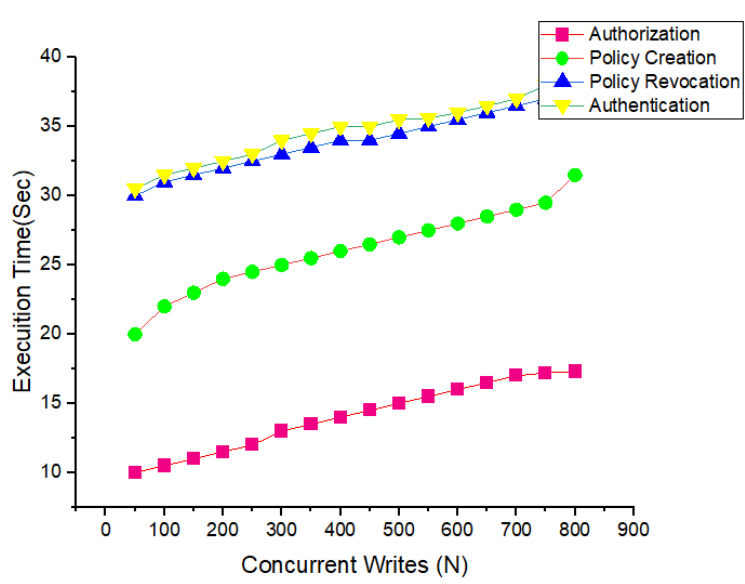
Figure 8. Simulation results of our proposed policies for access control.